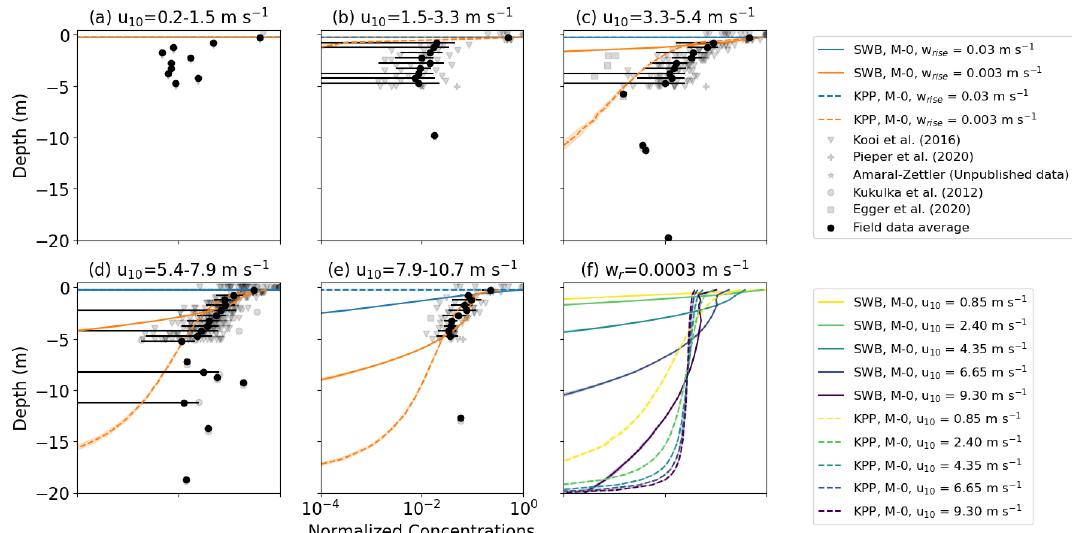
Figure 2. Vertical concentrations of buoyant particles for KPP and SWB diffusion using M-0 models. Panels (a) – (e) show the vertical concentration profiles for high- and medium-buoyancy particles with increasing wind speeds. The KPP profiles are calculated for θ = 1 . 0 and z 0 according to Eq. (12). The grey markers indicate field measurements, with darker shades indicating more measurements, while the binned field measurement average and standard deviation are shown by the black markers. Panel (f) shows the vertical concentration profiles for low-buoyancy particles under increasing wind conditions. Shading around the profiles indicates the profile’s standard deviation at each depth level.